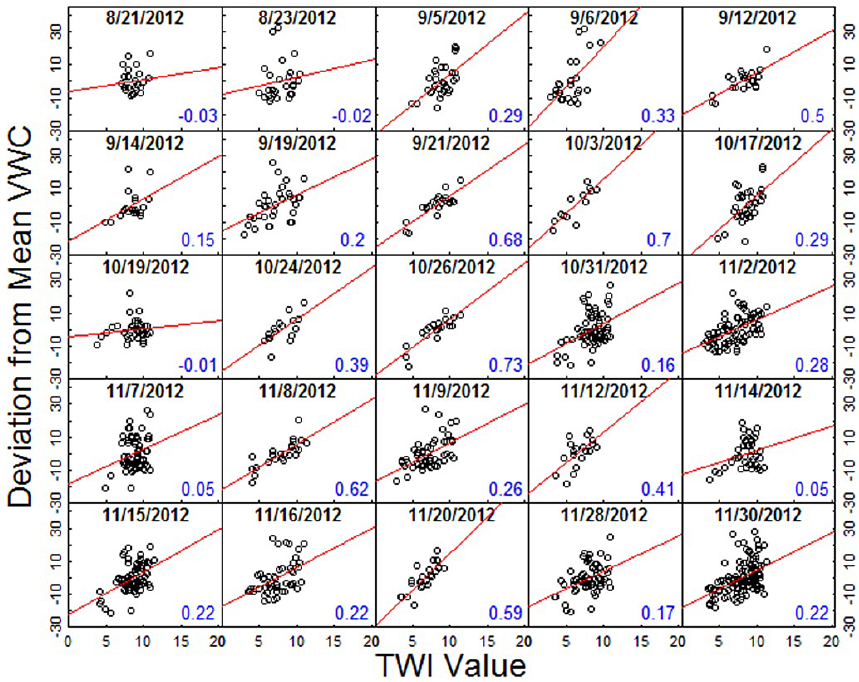
Figure 12. Mean-normalized volumetric water content (%) vs. index value of the optimal TWI for the USGS data set. R 2 values are shown in the lower-right corner of each